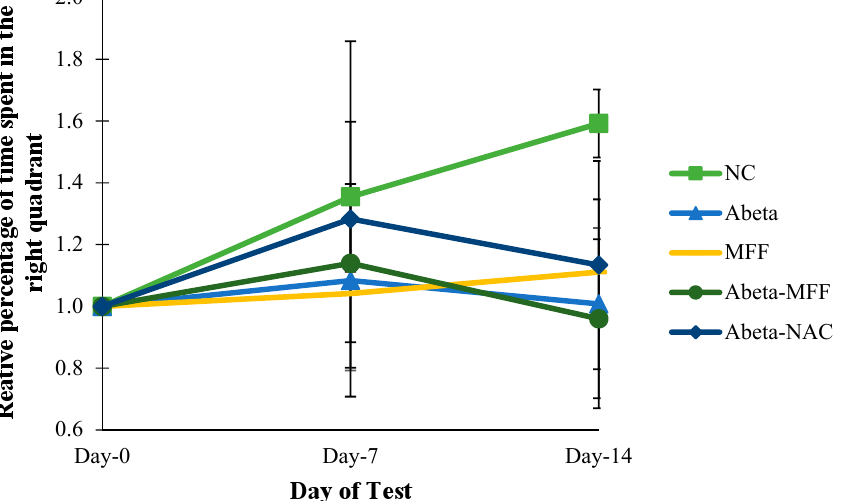
Figure 2. Comparison of the relative percentage of the time spent in the right quadrant on day 0, day 7 and day 14. Every bar represents the mean ± SEM ( n = 5). NC: normal control; Abeta: amyloid-beta; MFF: mixed functional foods; NAC: N-acetylcysteine.